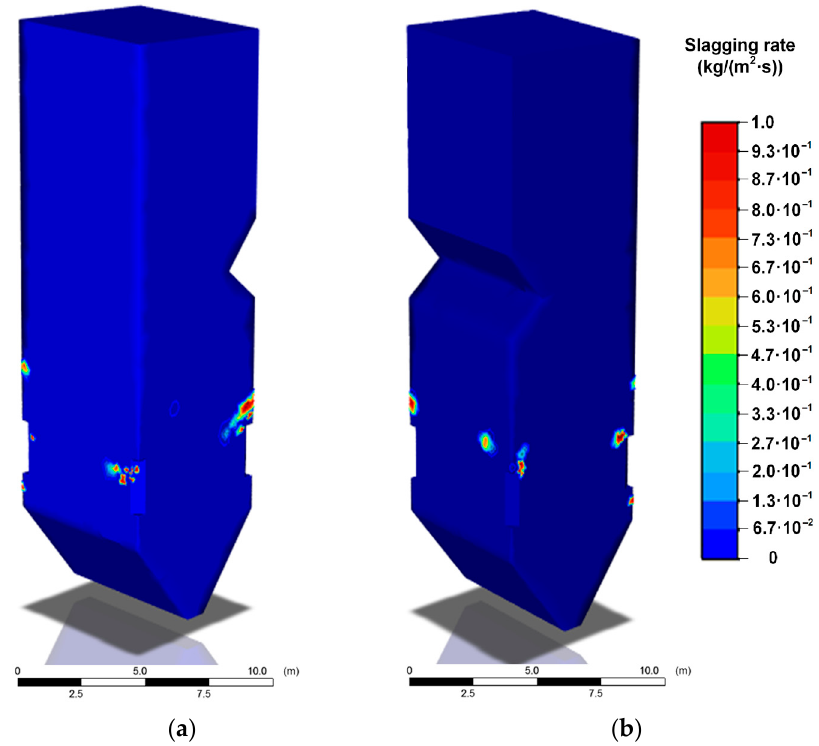
Figure 7. Typical fields of slagging rates of furnace walls when burning CWS: from the front side of the furnace ( a ); from the back side of the furnace ( b ).